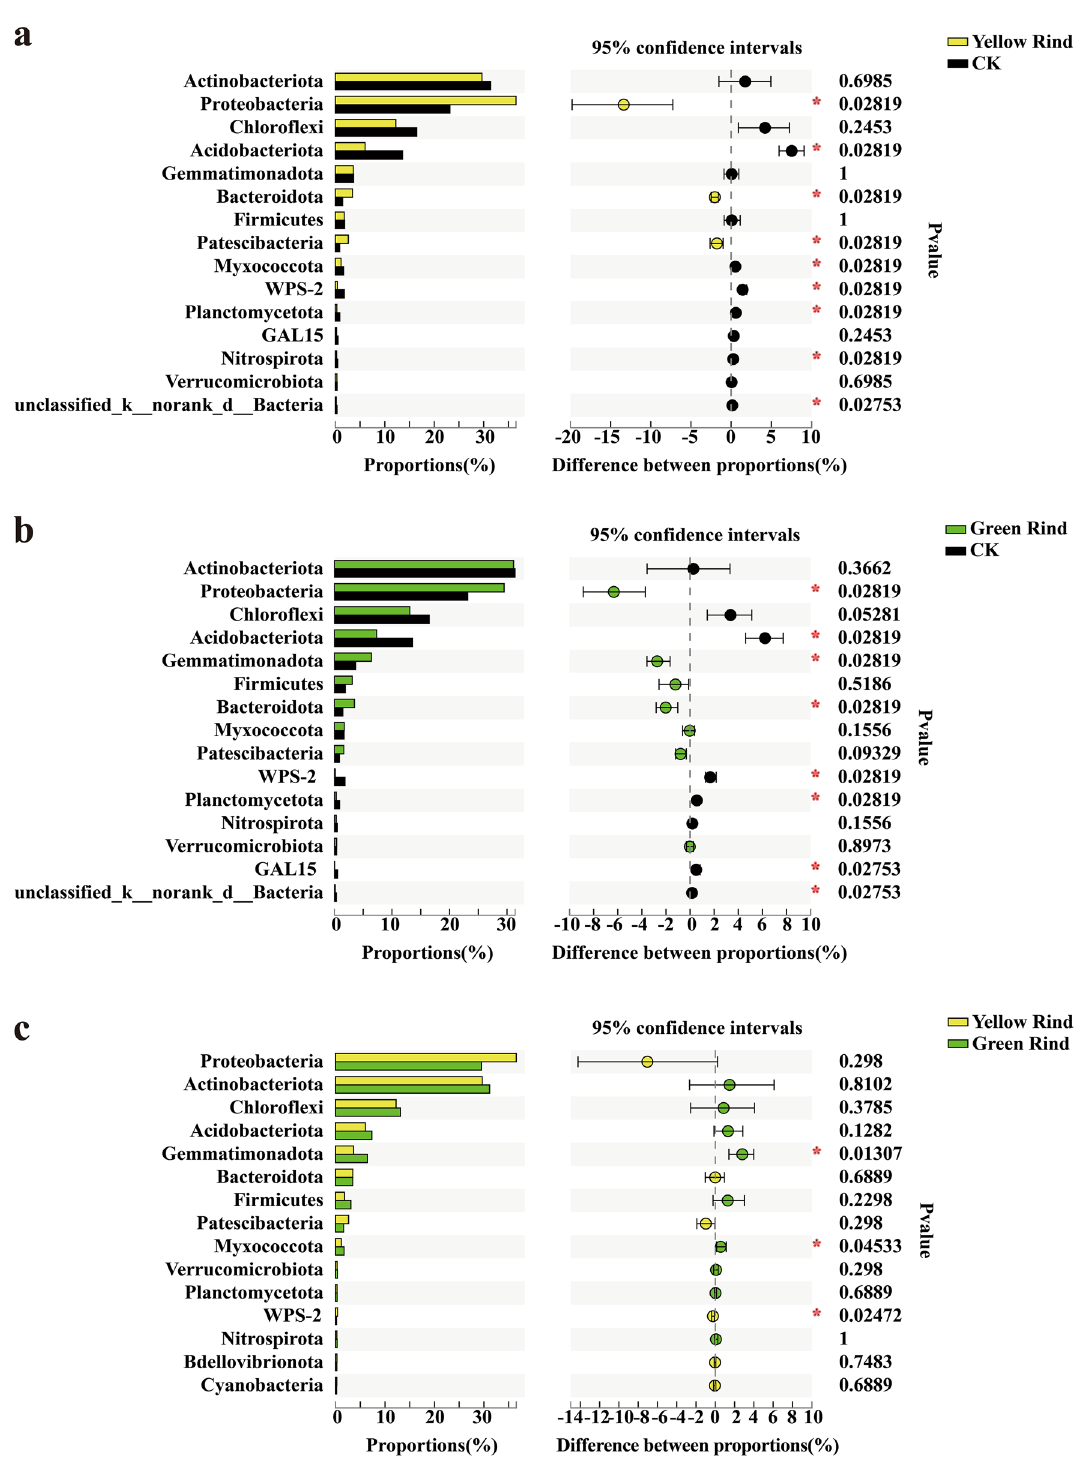
Figure 3. Difference test of soil bacteria between each group among yellow, green and CK at phylum level. *0.01 < p ≦ 0.05, **0.001 < p ≦ 0.01, *** p ≦ 0.001. (Sequences that could not be classified into any known group were assigned as “unclassified”. Some intermediate ranks in the taxonomic spectrum appeared in the comparison database without scientific names and were assigned as “norank”. That was, this rank was not